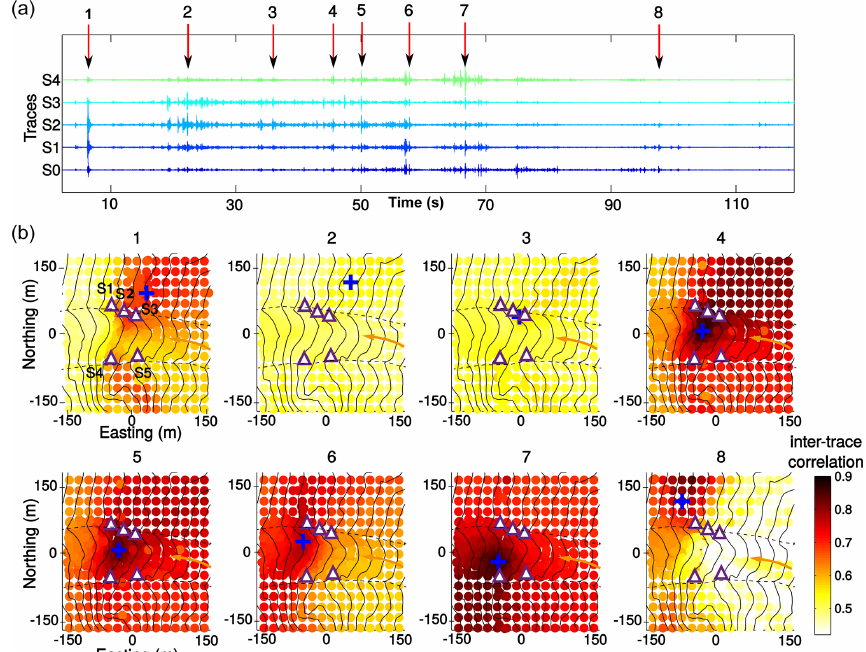
Figure 3. (a) Seismic waveforms of multiple successive rockfalls that occurred on 2 August 2019, as recorded by the five sensors (de- noted S1–S5 and indicated by triangles on the maps of subplots b ). The main impacts (denoted 1–8) are automatically located by the beam-forming method. (b) Spatial distribution of the inter-trace correlation for each of the eight impacts. The optimum location is indicated by a blue cross. The elevation contours are displayed every 25m. The yellow arrow indicates the downward propagation of the rockfalls in the